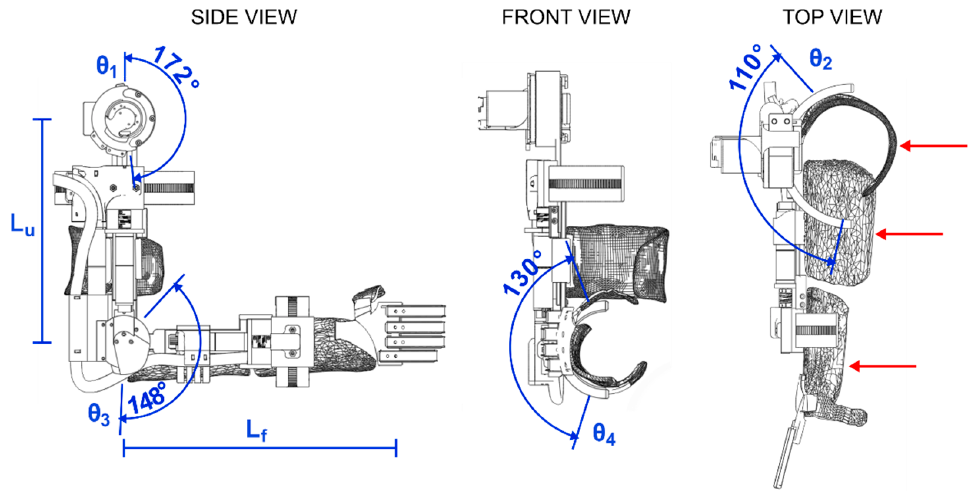
Figure 3. Detailed drawings of the EXOTIC exoskeleton and the range of motion of the four main degrees of freedom contributing to gross motion. From left: side view with shoulder ( θ 1 ) and elbow ( θ 3 ) flexion/extension and indications of link lengths (L u and L f ), which are adjustable; front view with wrist ( θ 4 ) supination/pronation; top view with upper arm internal/external rotation ( θ 2 ) and red arrows that indicate the three braces used to support the arm. Notation corresponds to the Denavit–Hartenberg parameters given in Table 2.